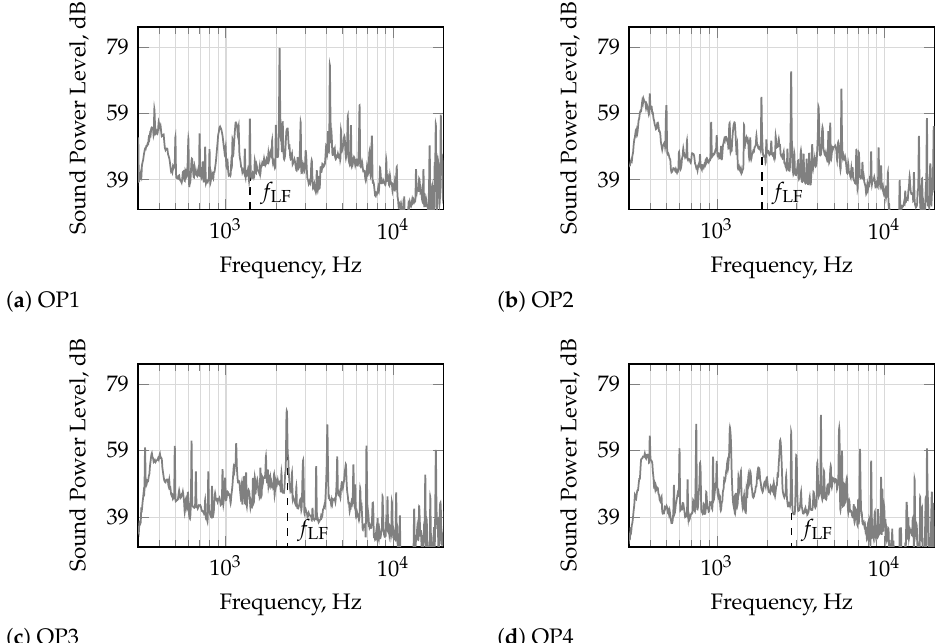
Figure 10. Narrowband L W,A of the electric powertrain with a dismounted axial fan stage operated at four operating